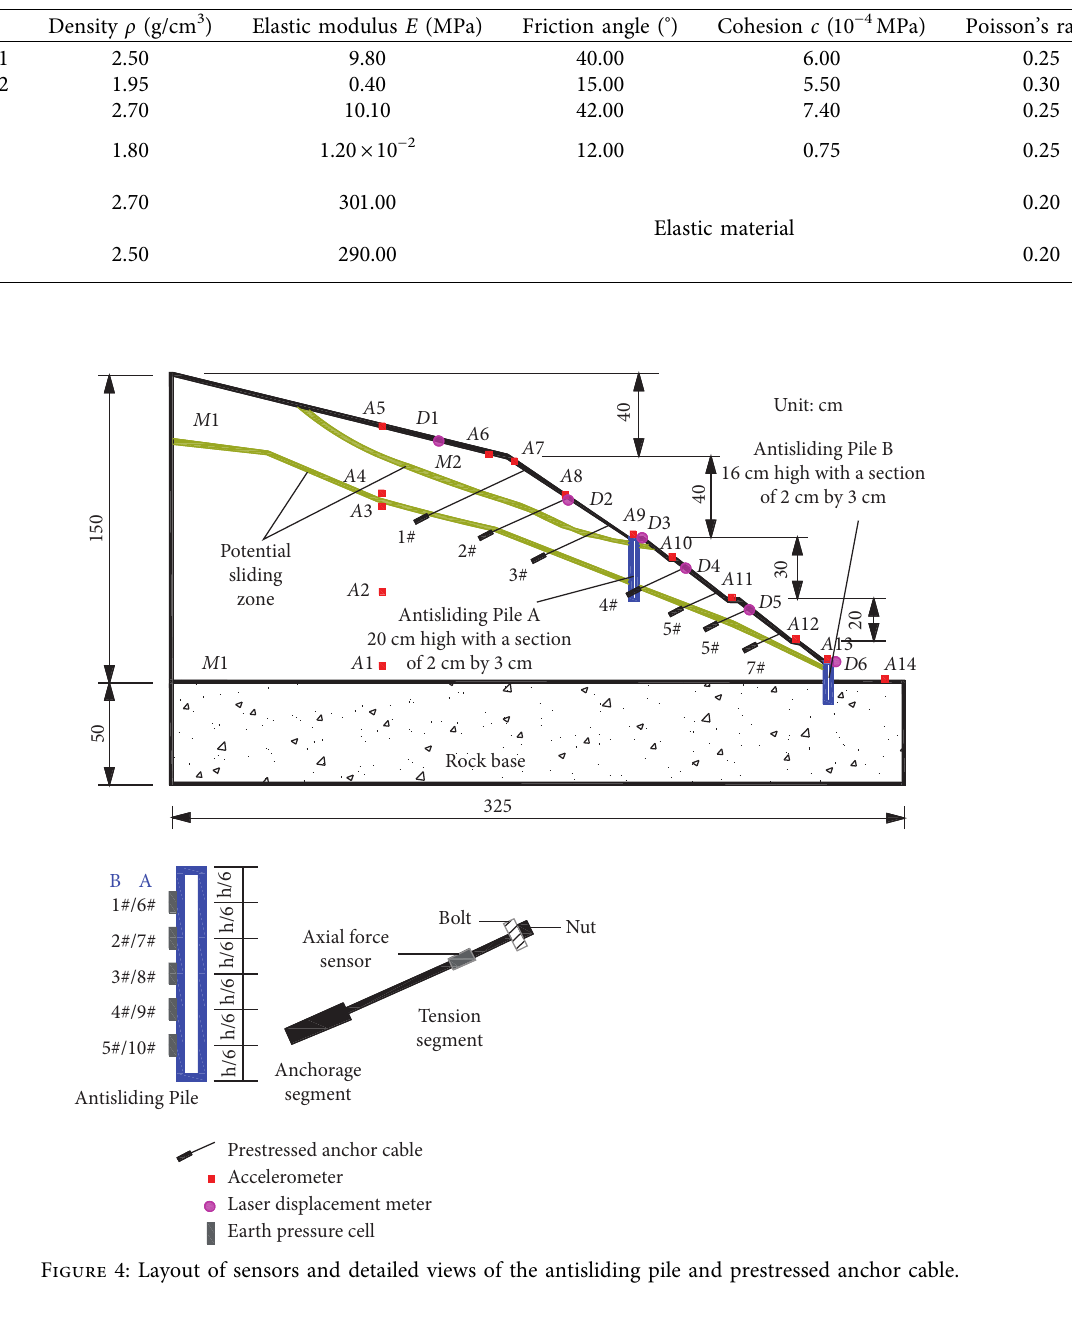
Table 3: Material parameters for the test model.